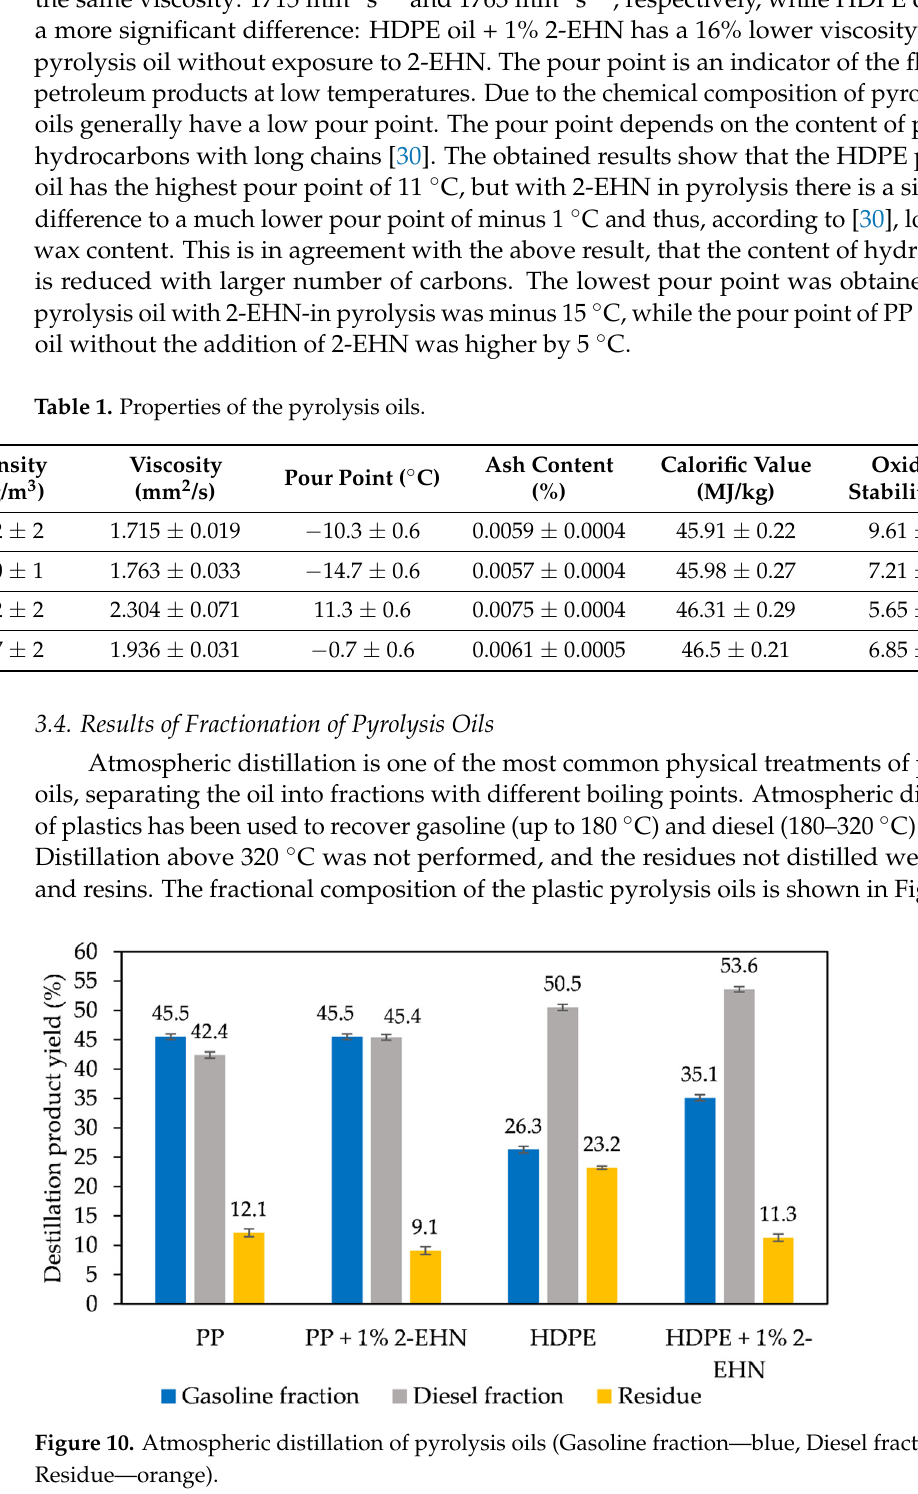
Table 1. Properties of the pyrolysis oils.